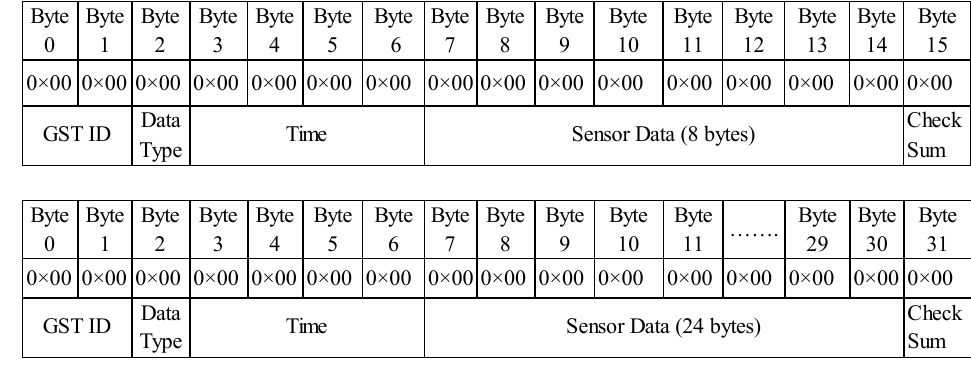
Figure 16. Short data packet format (16 bytes) ( top ) and long data packet format (32 bytes) ( bottom ).